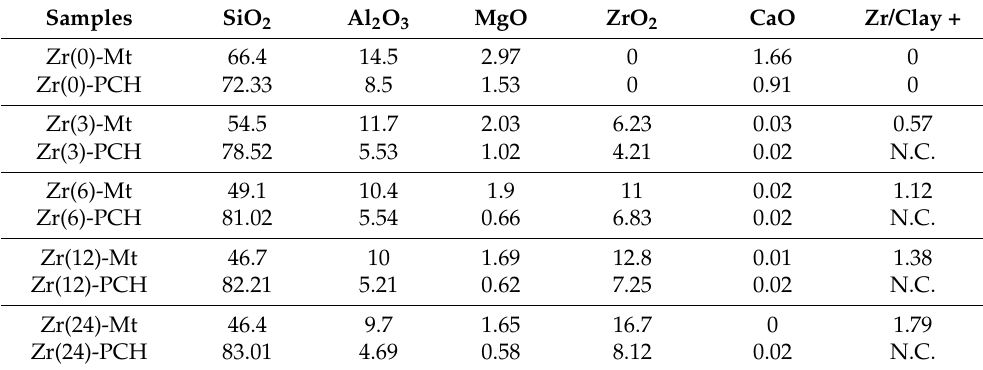
Table 1. XRF analysis of Zr(X)-Mt precursors and Zr(X)-PCH derivatives. Samples